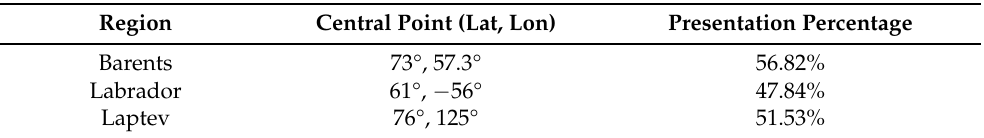
Table 2. Central points of projections. The presentation percentage is a fraction of satellite data present in each region relative to the region’s size (in cells). The lack of data is due to recognition errors and the presence of land (where SIC does not make